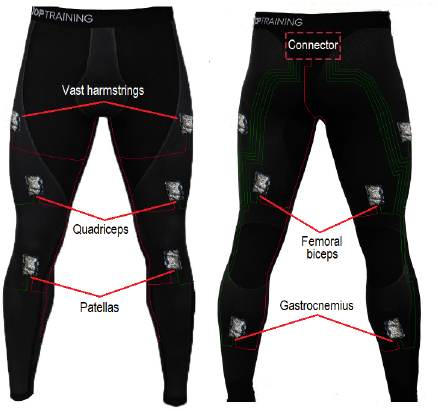
Figure 2. Location of the textile pressure sensors on the expandable fabric pants.